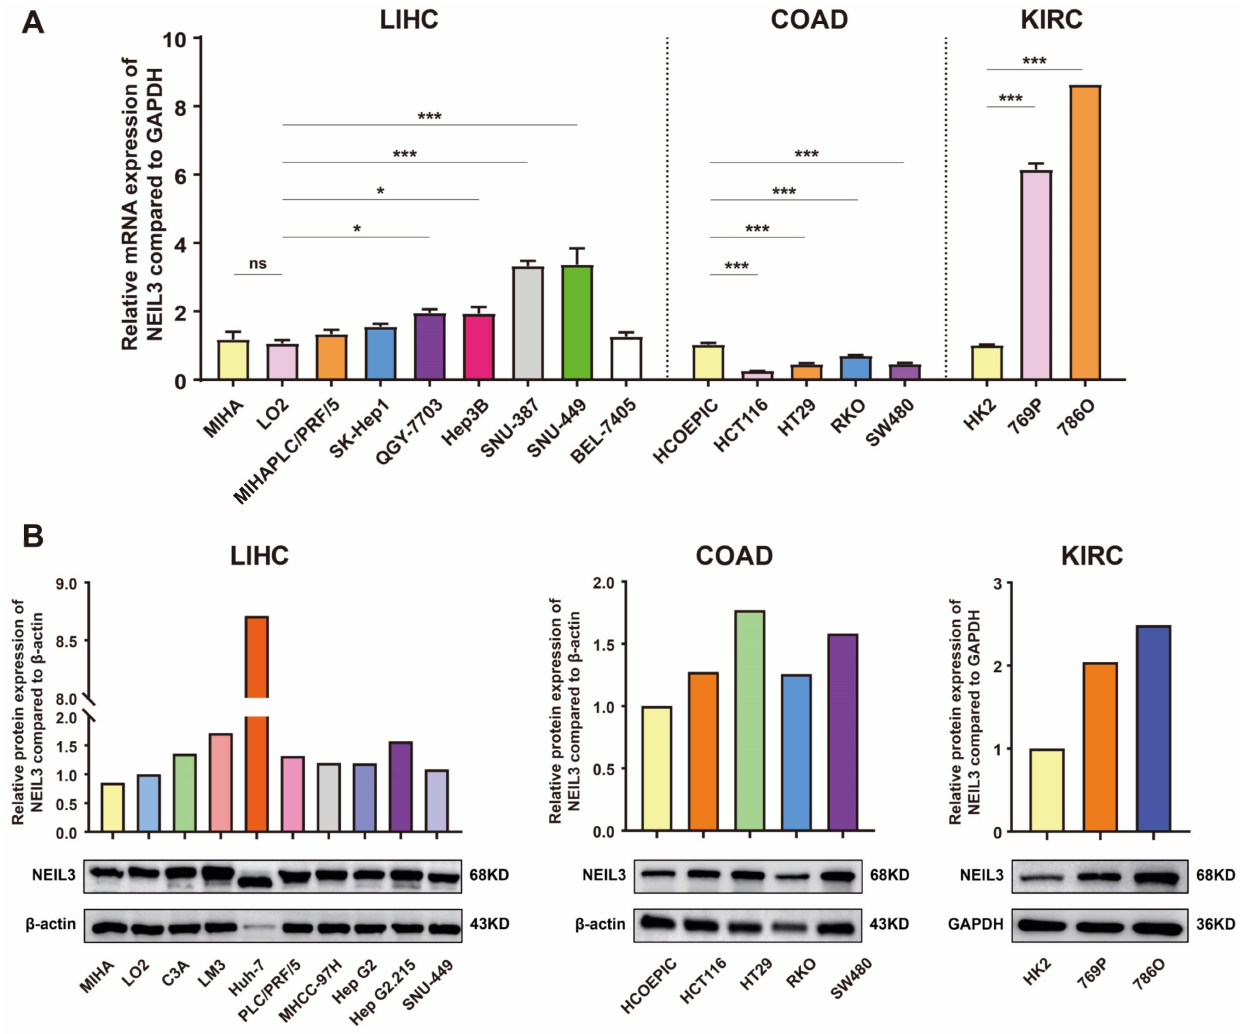
Figure 2. Experimental validation of the expression and prognosis of NEIL3 in cancers. (A) mRNA expression of NEIL3 in LIHC, COAD, and KIRC cell lines. (B) Protein expression of NEIL3 in LIHC, COAD, and KIRC cell lines, as well as their quantitative results. ( C ) mRNA expression of NEIL3 in 12 patients’ LIHC and paired adjacent liver tissues. ( D ) Representative images of IHC staining of HCC patient samples with low and high NEIL3 expression. ( E ) Difference in OS between high and low NEIL3 expression groups. ns indicates no significance, * p < 0.05, *** p <